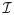
Intrinsic noise can increase or decrease information transfer in threshold genetic systems.(A) Any transmission of signals (x) that could lead to an error in the output (y) can be framed as a noisy information channel. The mutual information I (MI) quantifies the dependence between input and output distributions, P(x) and P(y), respectively, and can discriminate some associations not detected by the correlation coefficient. For instance, the cartoon illustrates two cases with the same correlation (represented by the eccentricity of the ellipses) but different MI. (B) The channel can describe a gene autoactivating its own expression (y) in a bistable OFF/ON manner, i.e., a simple example of threshold regulatory circuit. Information transfer depends on the relationship between x and the threshold value of activation (x and y in arbitrary units). Three instances of P(x) are shown (uniform distributions with different means; the blue one corresponds to a mean equal to the threshold value). When the signal is always beyond the threshold (red distribution) the circuit exhibit a nonzero MI only when it works stochastically (note the output distributions). Here we considered a binary response (OFF if y < 1, ON otherwise). (C) Resonance in MI as a function of intrinsic noise for the red P(x) in (B). MI values computed with the responses of the device to 104 different signals drawn from the described distribution. Responses are shown explicitly for three noise strengths (inset figures, black dots), together with its averaged stimulus-response profile (red curve). The maximum in MI occurs when the averaged stimulus-response profile is more linear (S1 Fig). (D) Other signal distributions, in which intrinsic noise always reduces MI, can nevertheless exhibit a resonance when the combined response of several units is considered (we show here the case of duplicated threshold devices; N = 2). Colors correspond to those distributions shown in (B). See Materials and Methods for details.